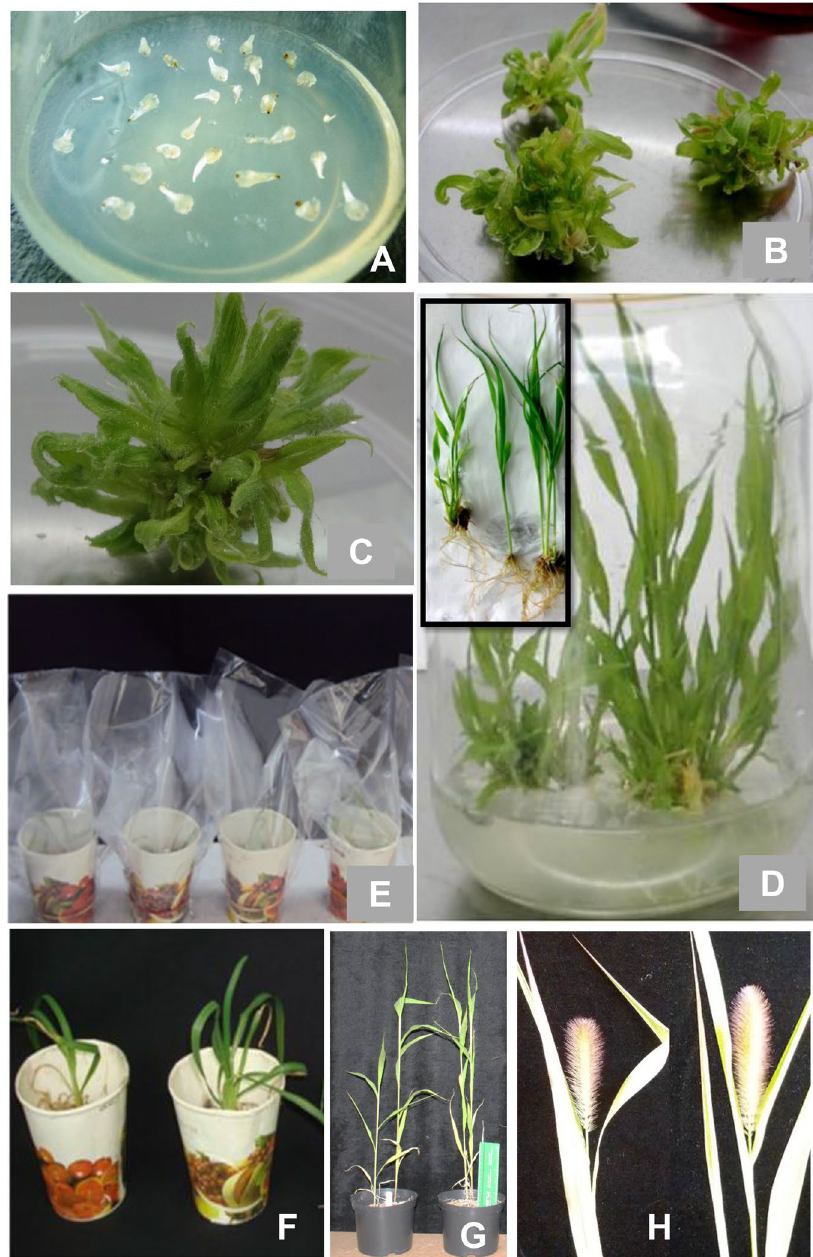
Figure 2. Direct plant regeneration from shoot apex explants foxtail millet genotype Maxima. Inoculation of shoot apex explants on MS medium containing BAP, after 3 days of incubation in the light ( A ), induction of multiple shoots on shoot induction medium (SIM) containing MS salts and 0.5 mg/L BAP, after 2 weeks of incubation in the light ( B ), Elongation of shoots in shoot elongation medium (SEM) consisting of MS salts, after one week of incubation in the light ( C ), rooting of shoots in the SEM after 3 weeks of incubation in the light ( D ). The inset figure shows the fully rooted plants removed from the vessels ( D ). Plants transferred from culture vessels to paper cups containing sterile vermiculite ( E ), paper cups were removed after 2 weeks ( F ), regenerated plants grown in green house, after 4 weeks of growth ( G ), seed setting in the in vitro regenerated plants ( H